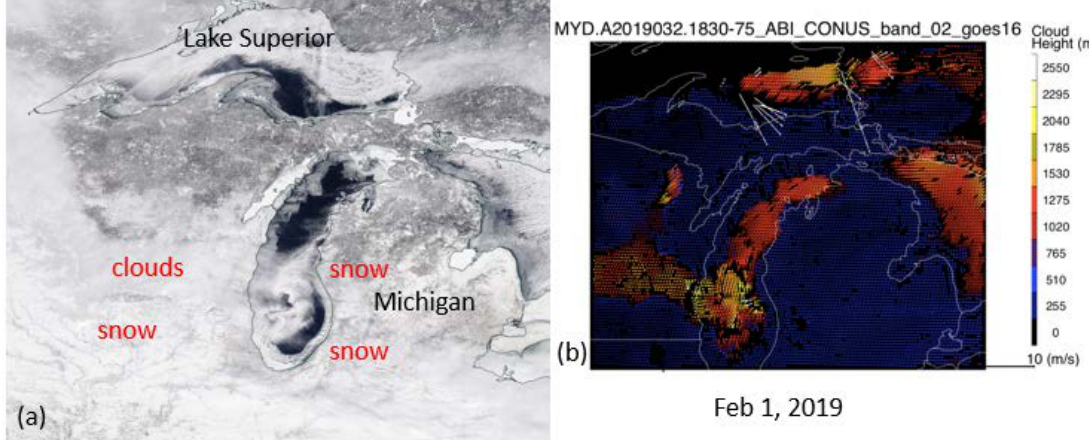
Figure 27. As in Figure 25 but for Feb.1, 2019 when the winds over Lake Michigan changed their direction drastically and the PBL clouds were aloft at the approximately same altitude.